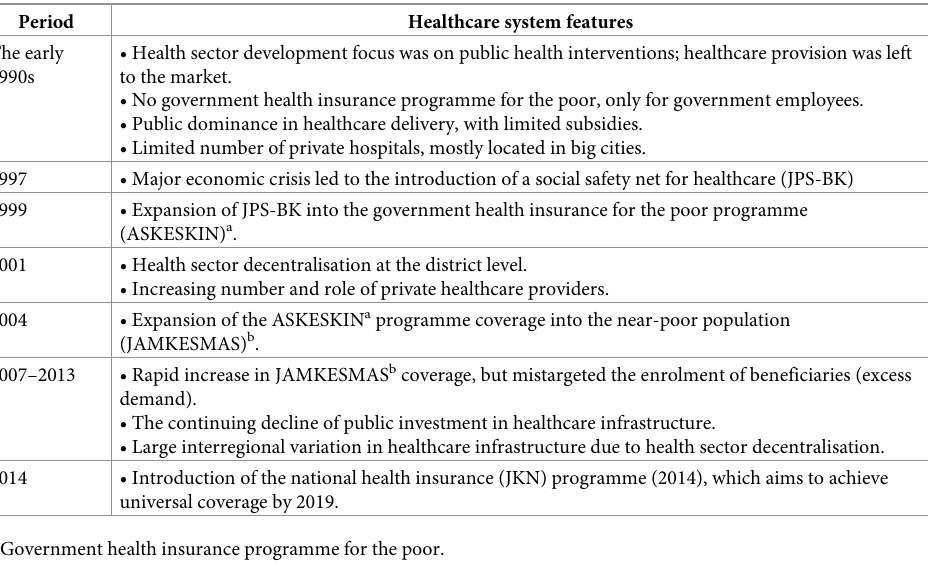
Table 1. Milestones of the Indonesian healthcare system from the early 1990s through 2014